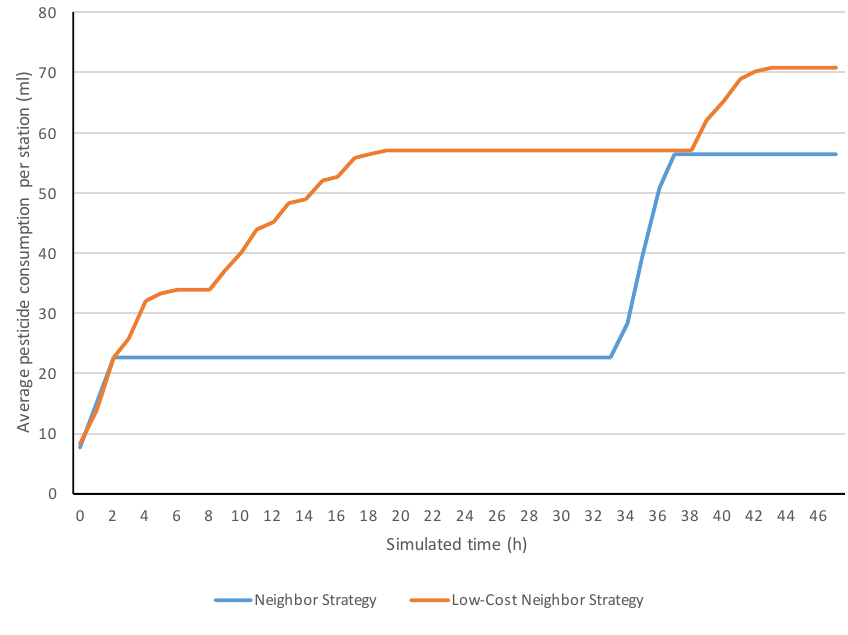
Figure 9. Simulation evolutions of average pesticide consumption per